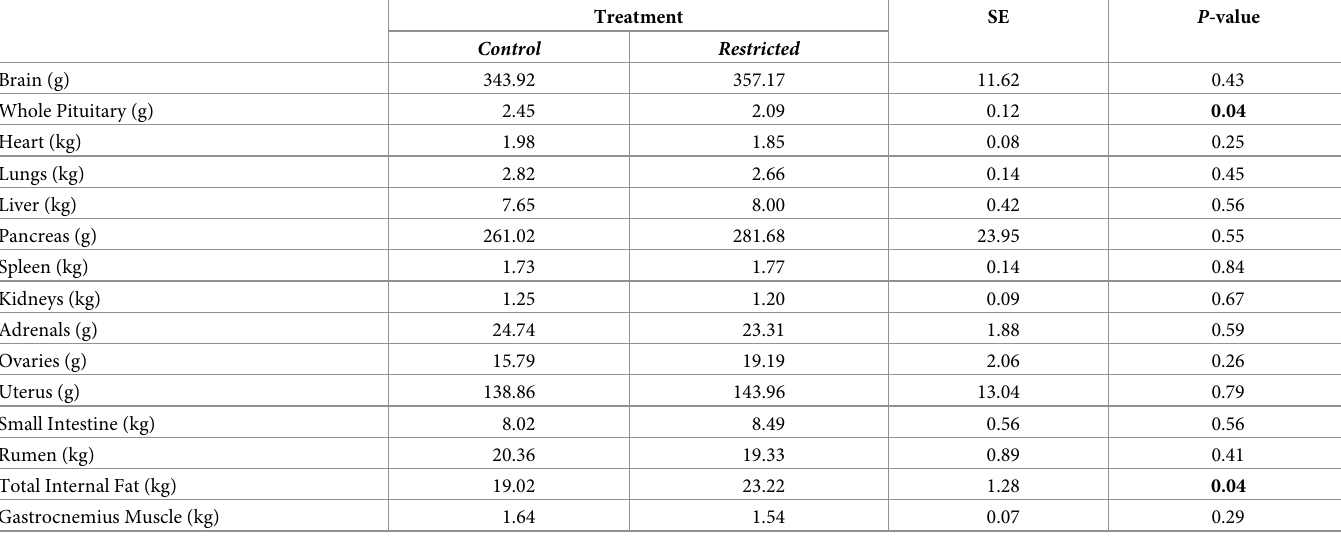
Table 6. Effects of maternal nutritional energy restriction (100% vs 70%) from GD 158 to parturition on organ weights of Angus cross offspring at PND 485 (n = 16).